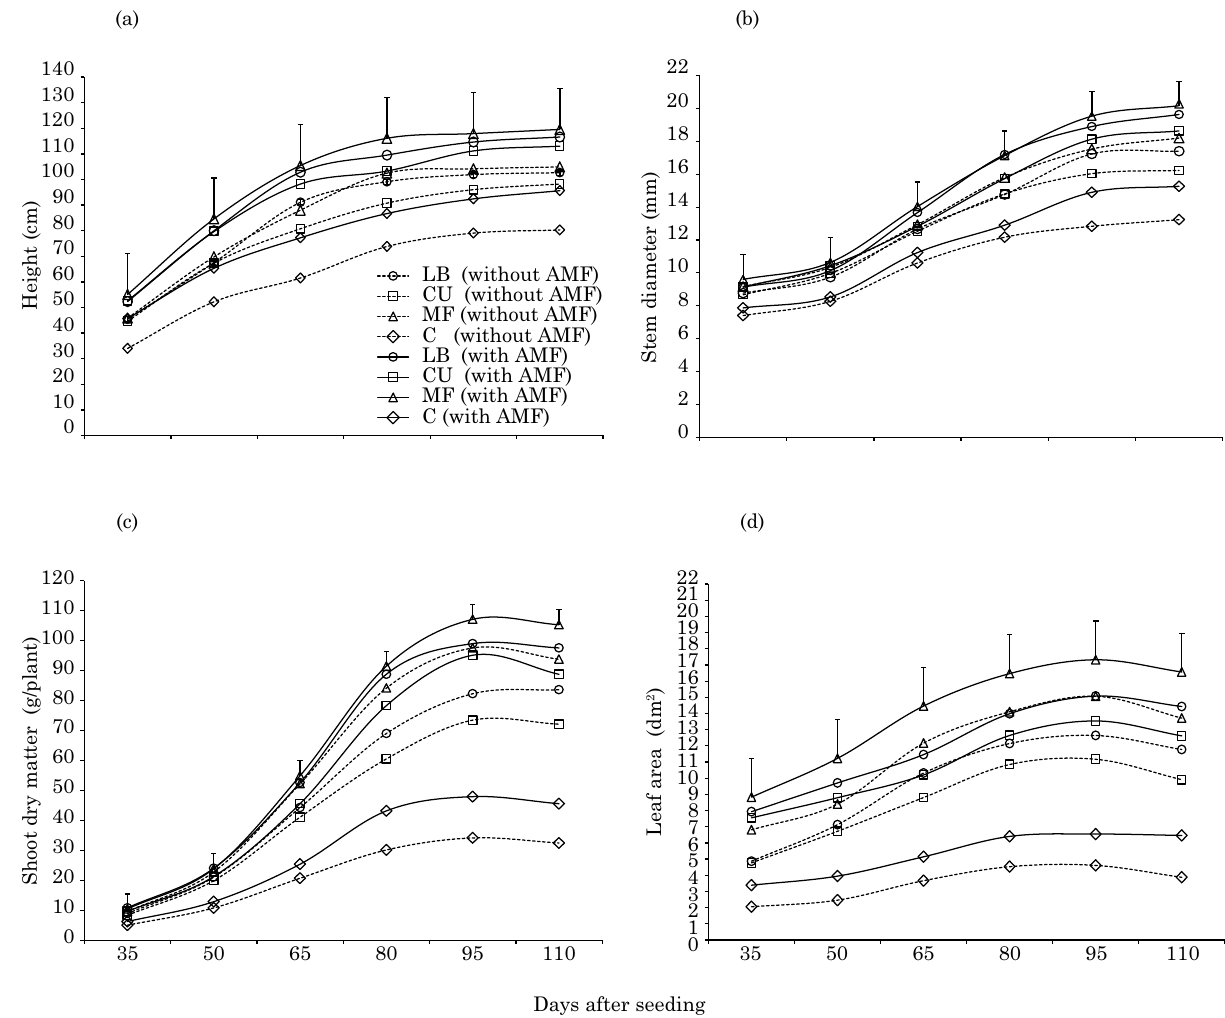
Figure 1. Plant height (a), stem diameter (b), shoot dry weight (c) and leaf area (d) of sunflower as a function of the application of fertilizers and time under cultivation. Vertical bars indicate LSD 0.05 for fertilization treatments within each time under cultivation. LB: liquid biofertilizer, CU: cow urine, MF: mineral fertilizer, and C: unfertilized treatment -